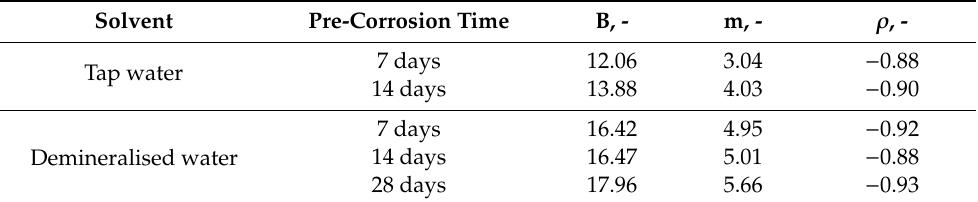
Figure 19. S-N data of AW-2017A-T4 material in nominal condition (room temperature, in air) and samples immersed in demineralised water solution for 7, 14 and 28 days prior to bending fatigue tests. 4. Discussion The paper described two series of fatigue tests of samples made of aluminium alloy AW-2017A under cyclic bending load, exposed to electrochemical corrosion caused by immersion in an electrolyte, a 3.5 wt% solution of NaCl in water. The first series of tests concerned a solution in tap water, and the second series concerned a solution in demineralised water. In each series, fatigue fractures indicated uniform crack propagation. The obtained test results feature Pearson correlation coefficient values between − 0.88 and − 0.90 in case of tap water solution and between − 0.88 and − 0.93 in case of demineralised water solution. The comparison showed a decrease in fatigue strength in each case except the 28 days of pre-corrosion serie. In this case it was slightly higher than the 7 and 14 days series, but it has to be mentioned that for this solution all S-N curves are very close to each other. The microscopic observations show that all samples of the tested alloy have undergone pitting corrosion. The smallest number of pits was formed on the sample after the shortest immersion duration (7 days, Figures 15a and 16a), more pits were visible on the samples immersed for 14 days (Figures 15b and 16b), which is consistent with the results obtained from fatigue tests. The observations indicate a disruption of the anode layer and the occurrence of micro cracks which transform into corrosion. In addition, it is not possible to create a passive layer on the surface of the